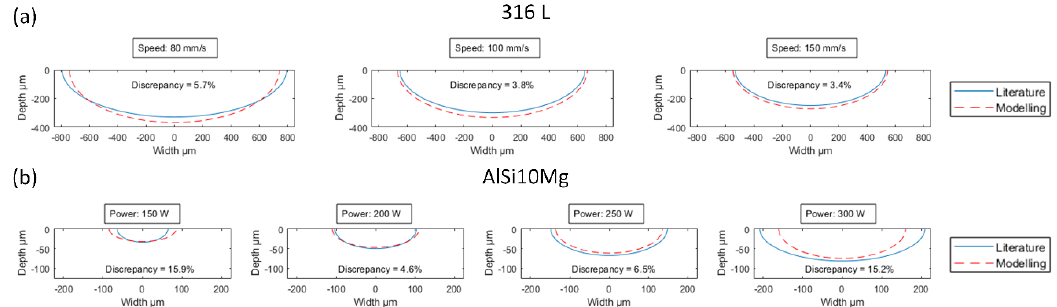
Figure 5. Comparison of the melt pools profiles for ( a ) 316L [11] and ( b ) AlSi10Mg [14] alloys.